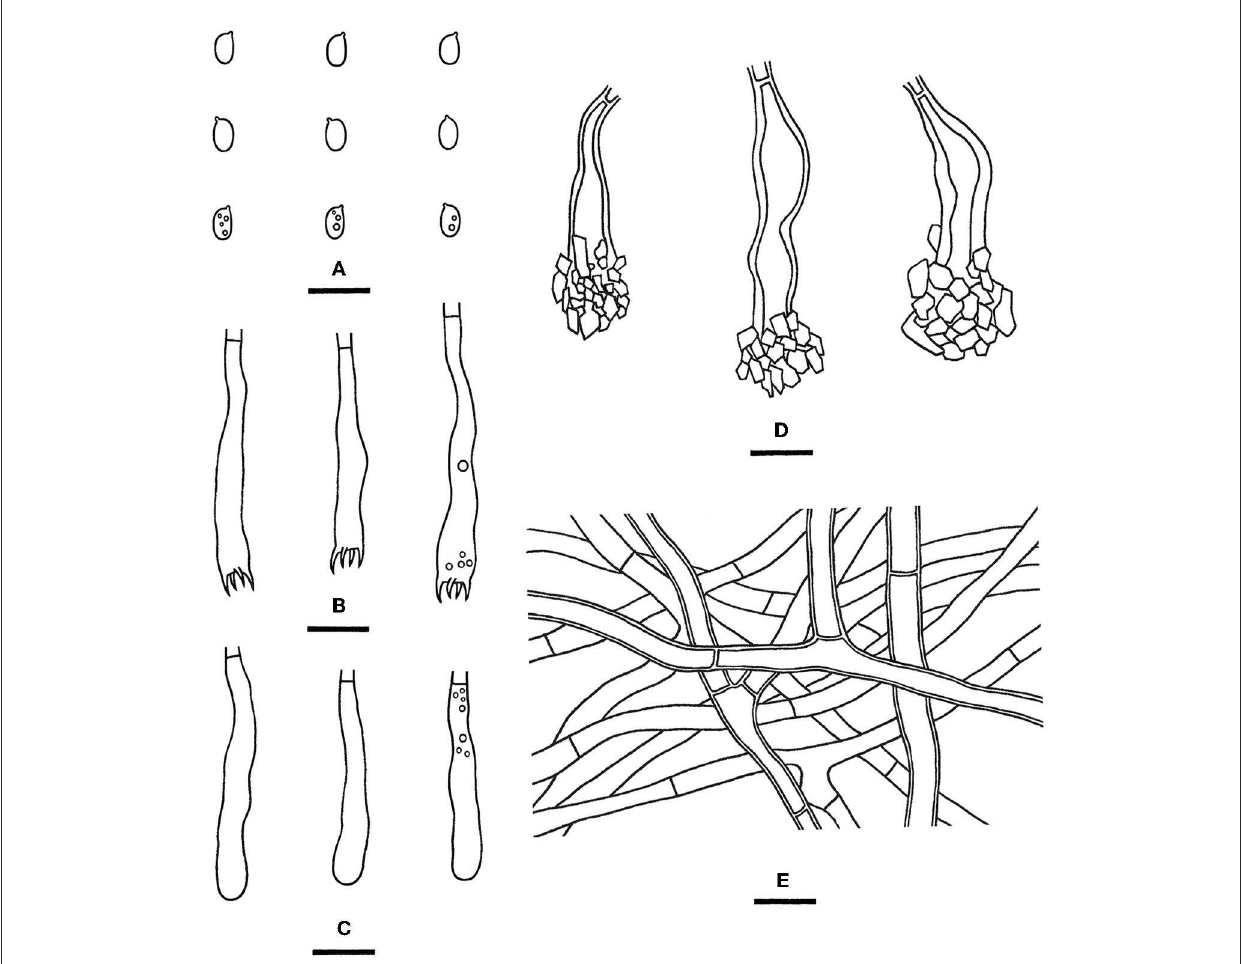
FIGURE12 Rhizochaete yunnanensis [from the holotype He 3302; scale bars: (A–E) = 10 µ m]. (A) Basidiospores; (B) Basidia; (C) Basidioles; (D) Lamprocystidia; (E) Hyphae from subiculum.